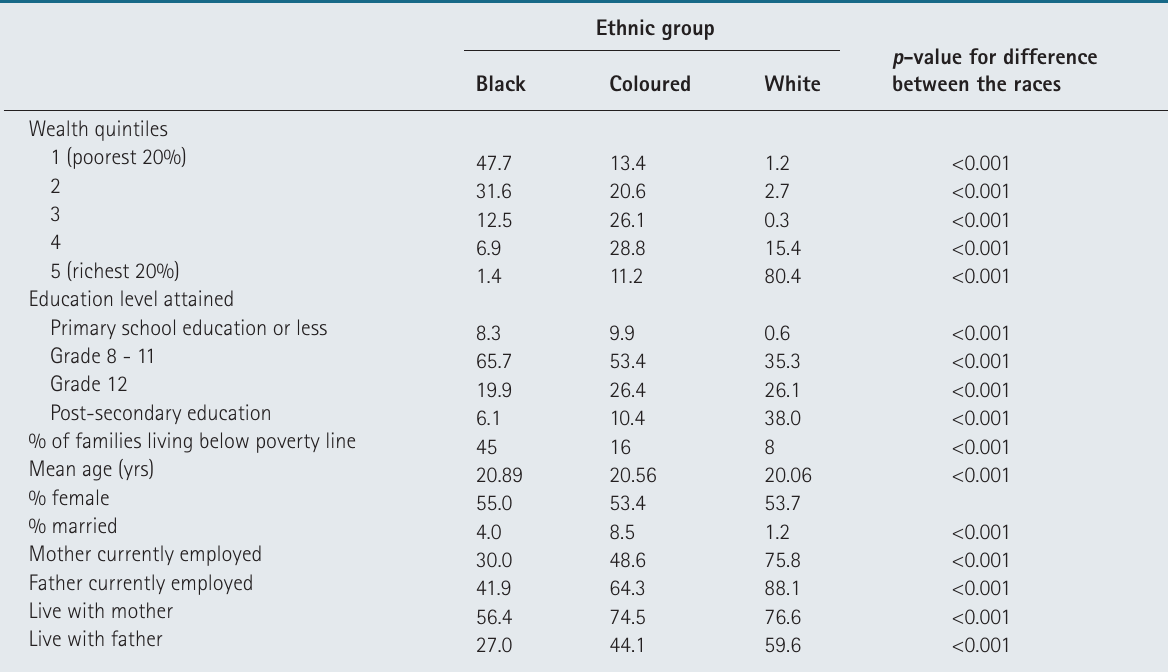
TABLE II. sOCIO-DEmOGRAphIC ChARACTERIsTICs BY RACE/EThNIC GROup